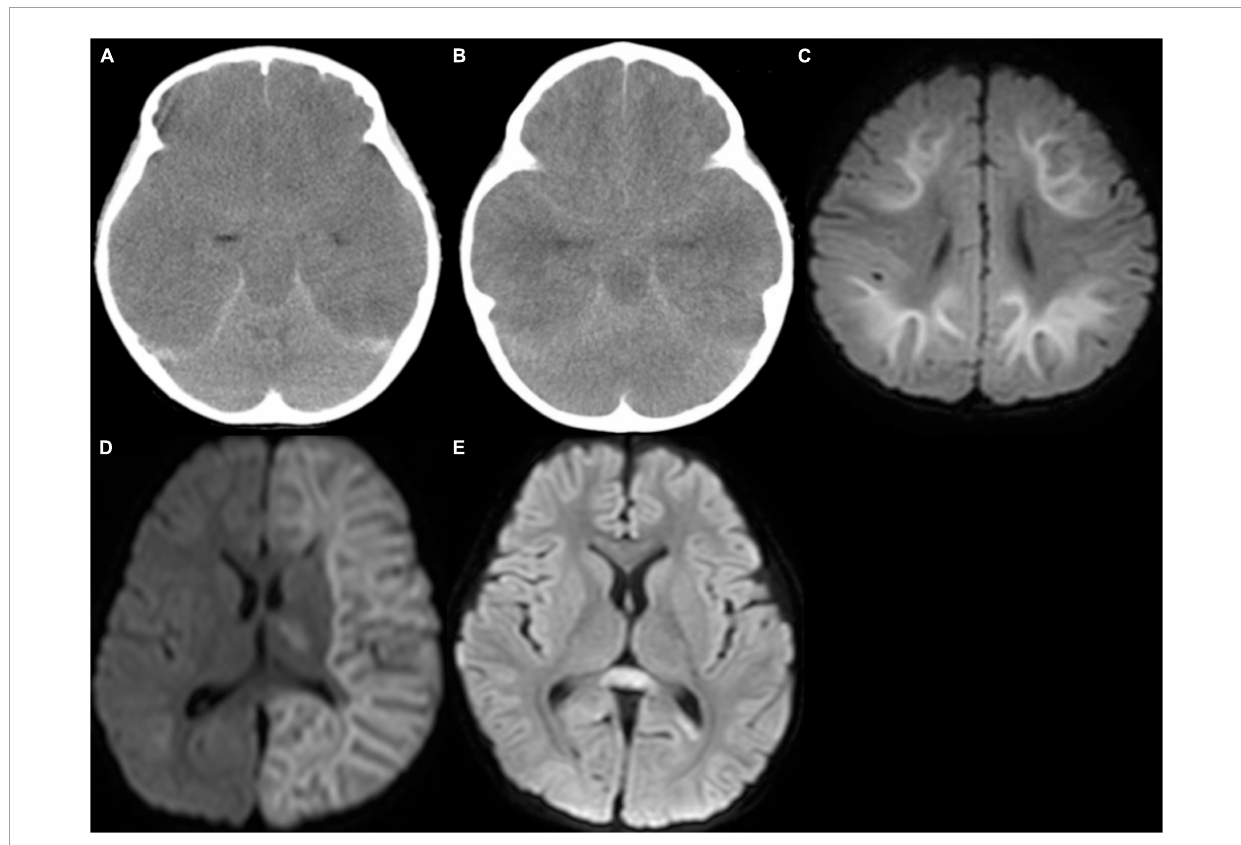
FIGURE2 Computed tomography (CT) and magnetic resonance imaging. (A) CT in a patient with encephalopathy with fulminant acute cerebral edema revealed diffuse low density in the cerebrum with blurring of gray-white matter junction, and disappearance of ambient cistern, suggesting severe cerebral edema with probable downward herniation. (B) CT in a patient with hemorrhagic shock and encephalopathy syndrome revealed severe cerebral edema. (C) Diffusion-weighted image in a patient with acute encephalopathy with biphasic seizures and late reduced diffusion (AESD) revealed high signal lesion in the subcortical white matter with sparing peri-Rolandic regions, so-called bright tree appearance. (D) Diffusion-weighted image of a patient with unilateral AESD revealed left-sided bright tree appearance (BTA) with a small lesion in the left ventral thalamus. (E) Diffusion-weighted image of a patient with mild encephalitis/encephalopathy with reversible splenial lesion (MERS) revealed a high signal lesion in the splenium of the corpus